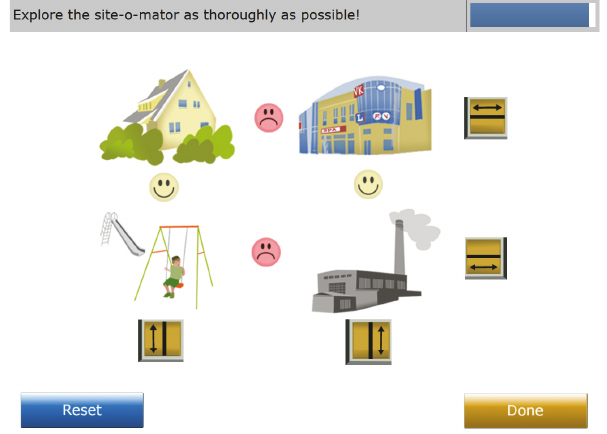
Figure1:ScreenshotoftheMicroFINitem“Plan-o-Maton”[49,50]. Problem solvers have to balance the interests of various parties in a city by making alterations in the urban landscape. Along the bottom and the right side: the keys for altering the location of the interest groups. In principle, two stakeholders change places when triggered. On the right side: a city mall and a factory. On the left side: a family home and a playground. Between these parties, smiley faces indicate the atmosphere. The problem solver has to improve the atmosphere by finding one of several optimal